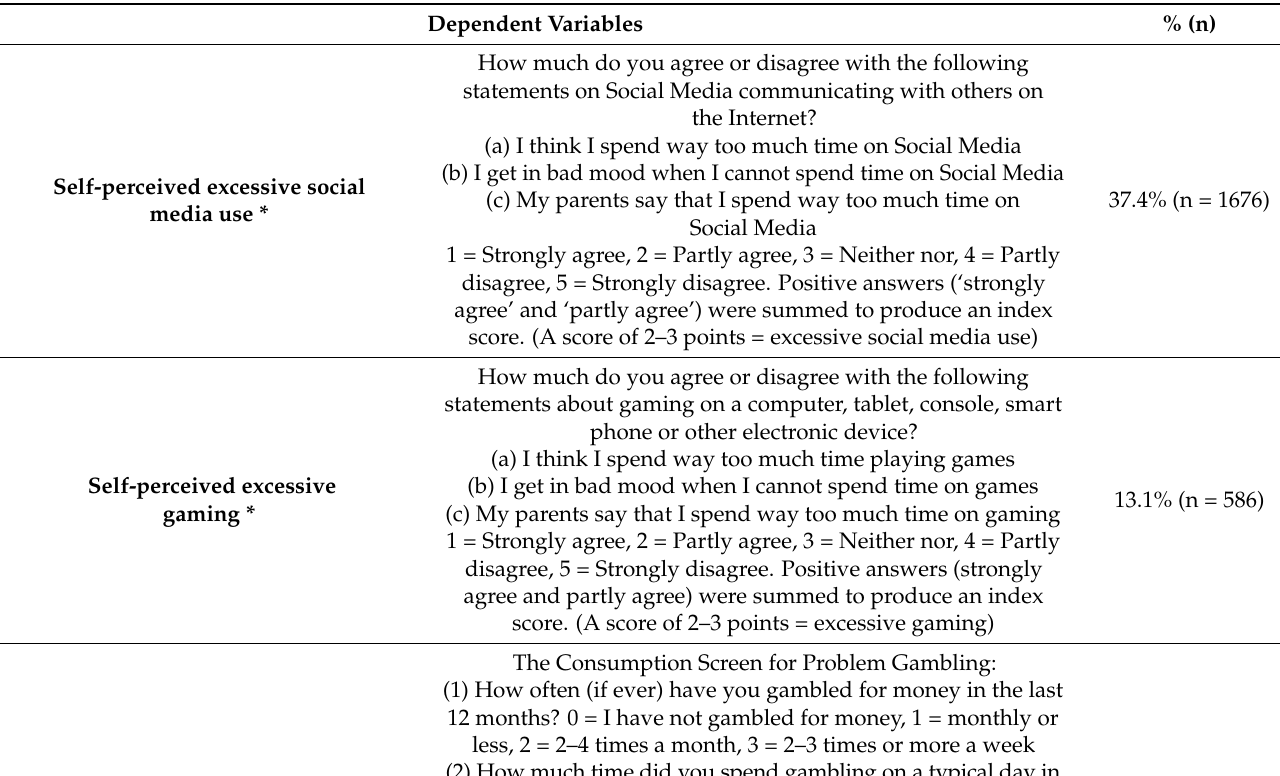
Table A1. Descriptions and weighted frequencies (%, n) of the dependent variables and the